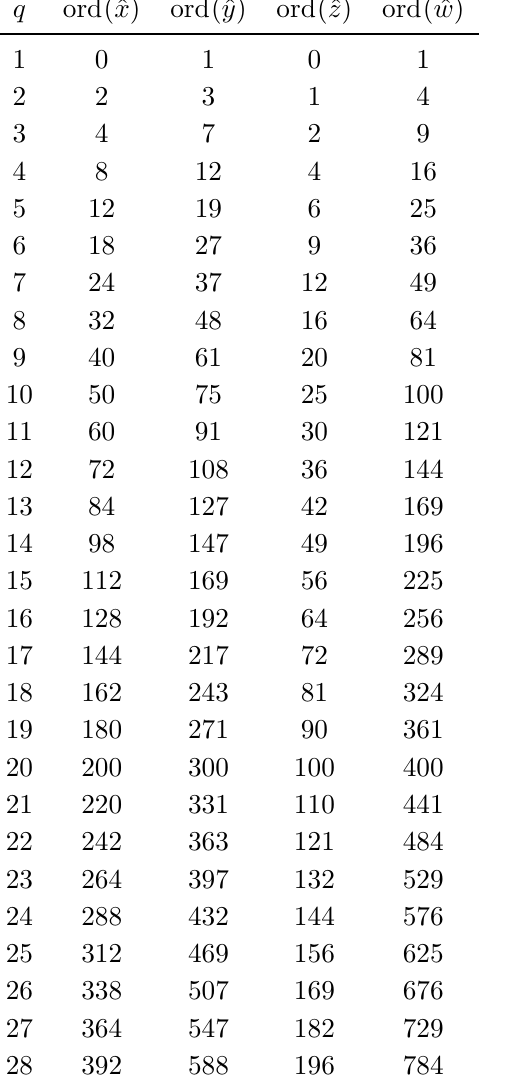
ˆ f 12 = 0 } . = ˆ f = 0 } , and the section q ˆ s realizes 9 12